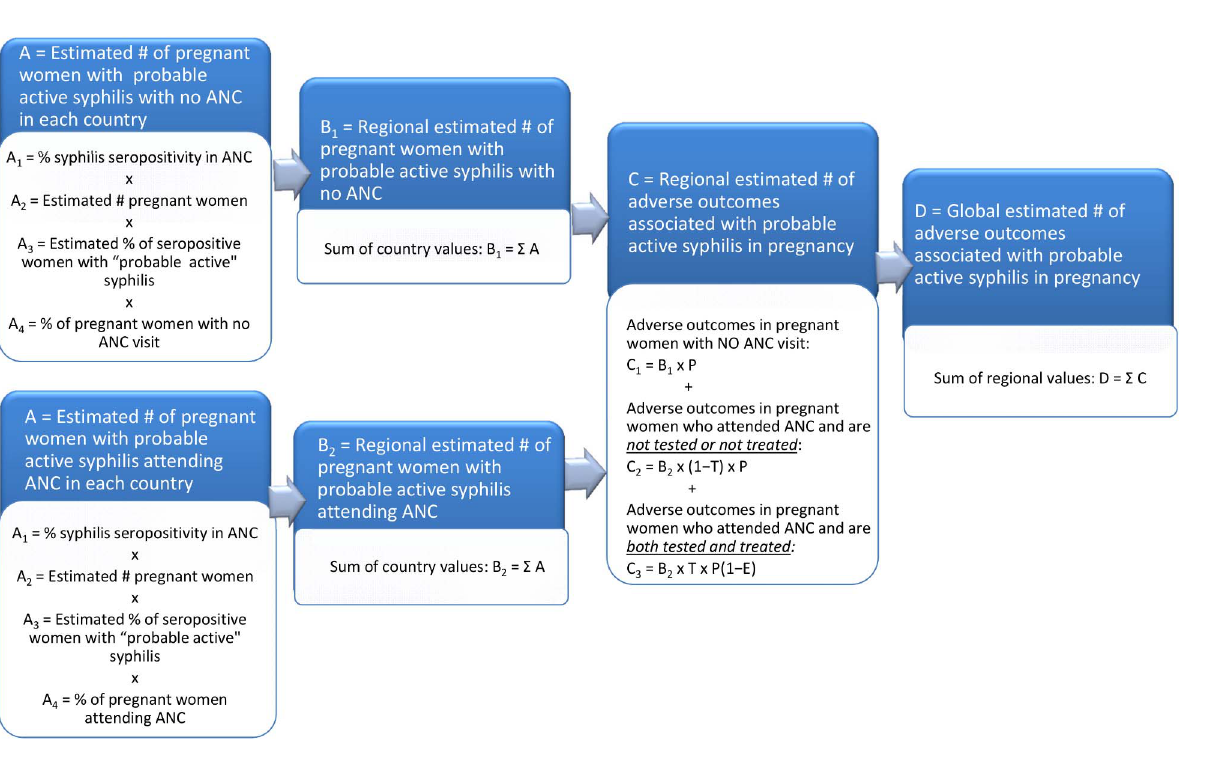
Figure 1. Flowchart of model to estimate number of adverse outcomes associated with syphilis in pregnancy. # , number.